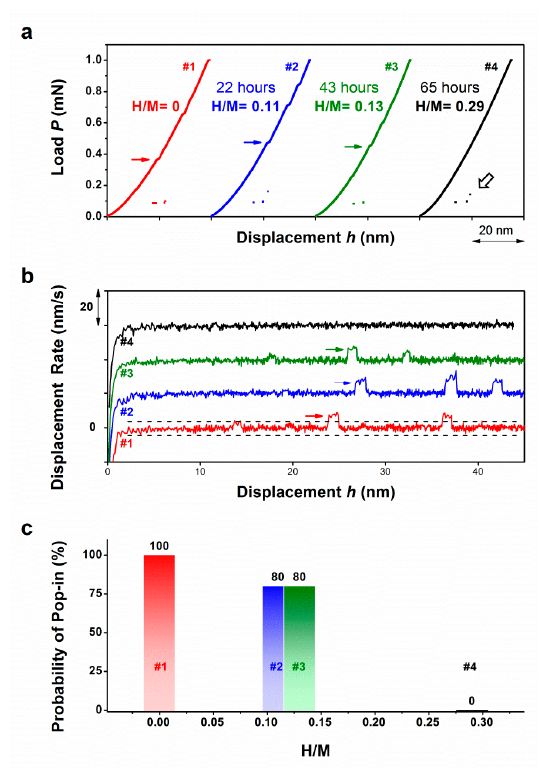
Figure 2. ( a ) Typical load displacement curves for indents in samples with different hydrogen content ( c H ). The curves are shifted for the sake of clarity. ( b ) Displacement rate as a function of displacement for each curve in (a). The first pop-ins are marked with arrows. The curves are shifted for the sake of clarity. ( c ) The percentage of indents that have no pop-in out of 144 tests in each sample.